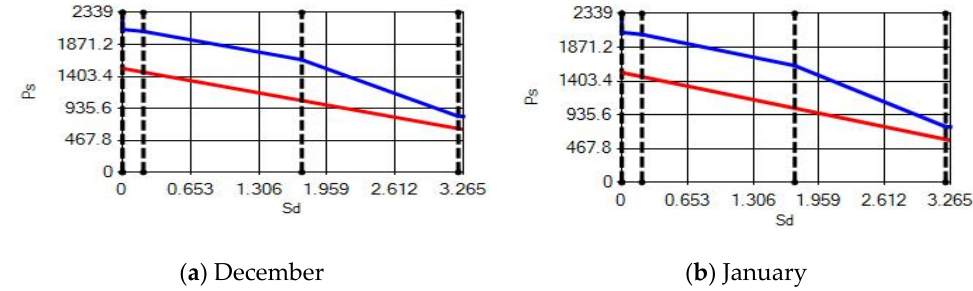
Figure 19. Condensation and evaporation amount chart for the building elements of the brick external wall for the 2nd zone for ( a ) December and ( b ) January.